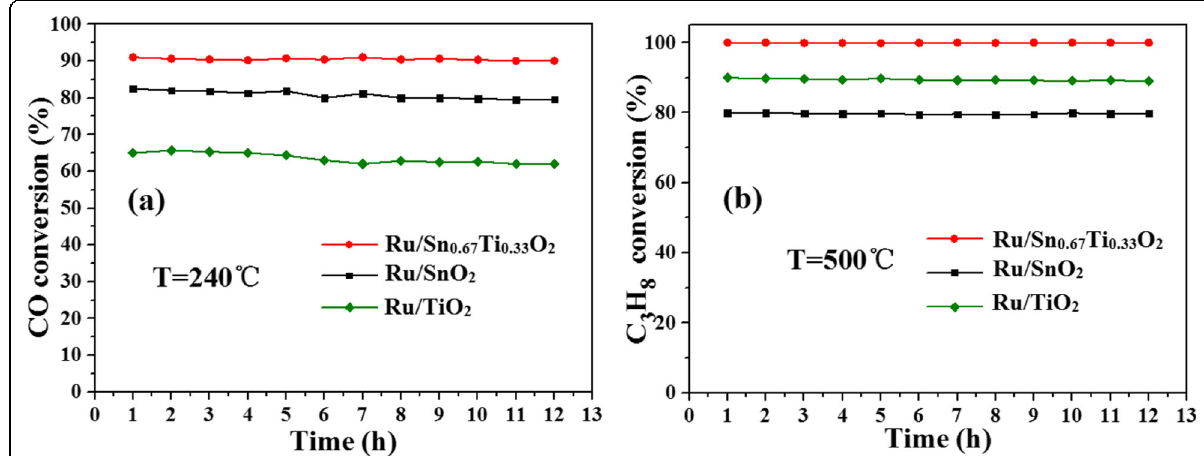
Fig. 3 The stability of Ru/Sn x Ti 1 − x O 2 catalytic CO ( a ) and C 3 H 8 ( b )